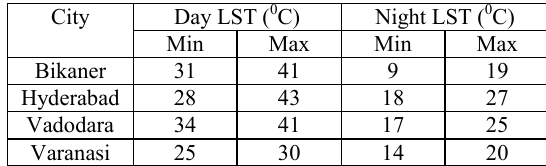
Table 3. Specification of day and night LST in the cities From Table 3, it was observed that different cities show different LST behaviour during day and night time. Bikaner shows very high LST during day time but very low during night time. Varanasi show lower LST during day time than other cities and the decrease in LST during night was found very low. Vadodara also shows high LST during day time but the decrease in LST during night time was less than that in Bikaner but higher than that in Varanasi. This was due to the presence of both sparse vegetation and bare soil in the rural areas. In Hyderabad, max LST was due to the rocks on the hills and min LST due to the waterbody in urban areas during day time but during night time urban areas shows higher LST and surrounding region show lower LST. Therefore, LST in urban areas do not show much variation from day to night time. Hence, the heat absorbed by the urban areas during day time gets trapped due to less covers was found to influence the LST value in urban